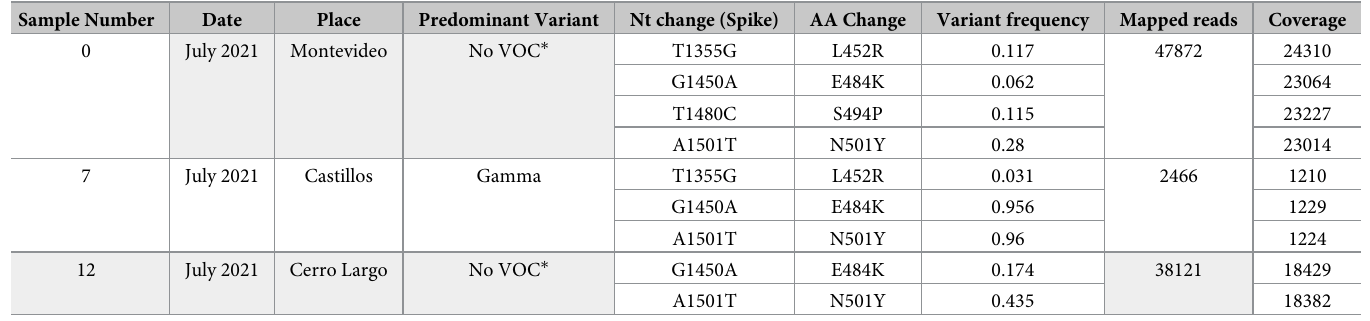
Table 3. Analysis using